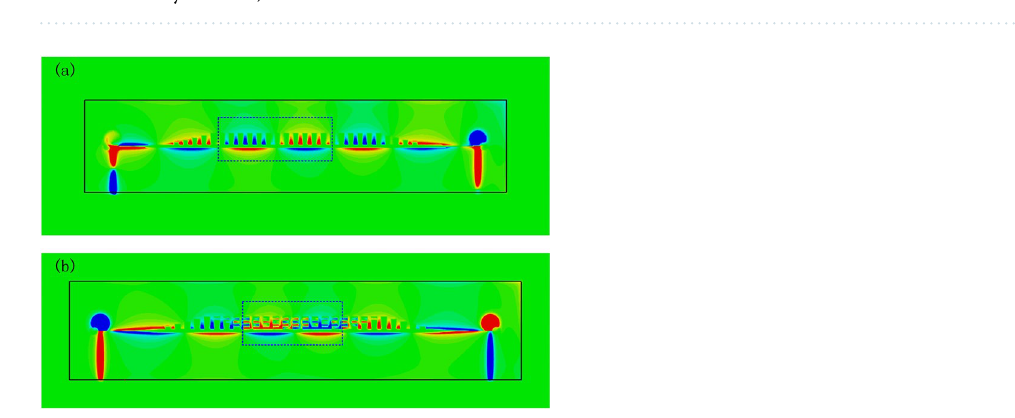
Figure 3. One-dimensional distribution of electric field along ( a ) curve 1 and ( b ) curve 2. The blue area marks the locations of the CSSPP structure (the main slot and IS-loaded grooves) and the substrate. (Curve 1: along y-direction from y = − 6 mm to 11 mm at x = 0 mm & z = − 0.2 mm; Curve 2: along z-direction from z = − 2 mm to 2 mm at x = y = 0 mm).